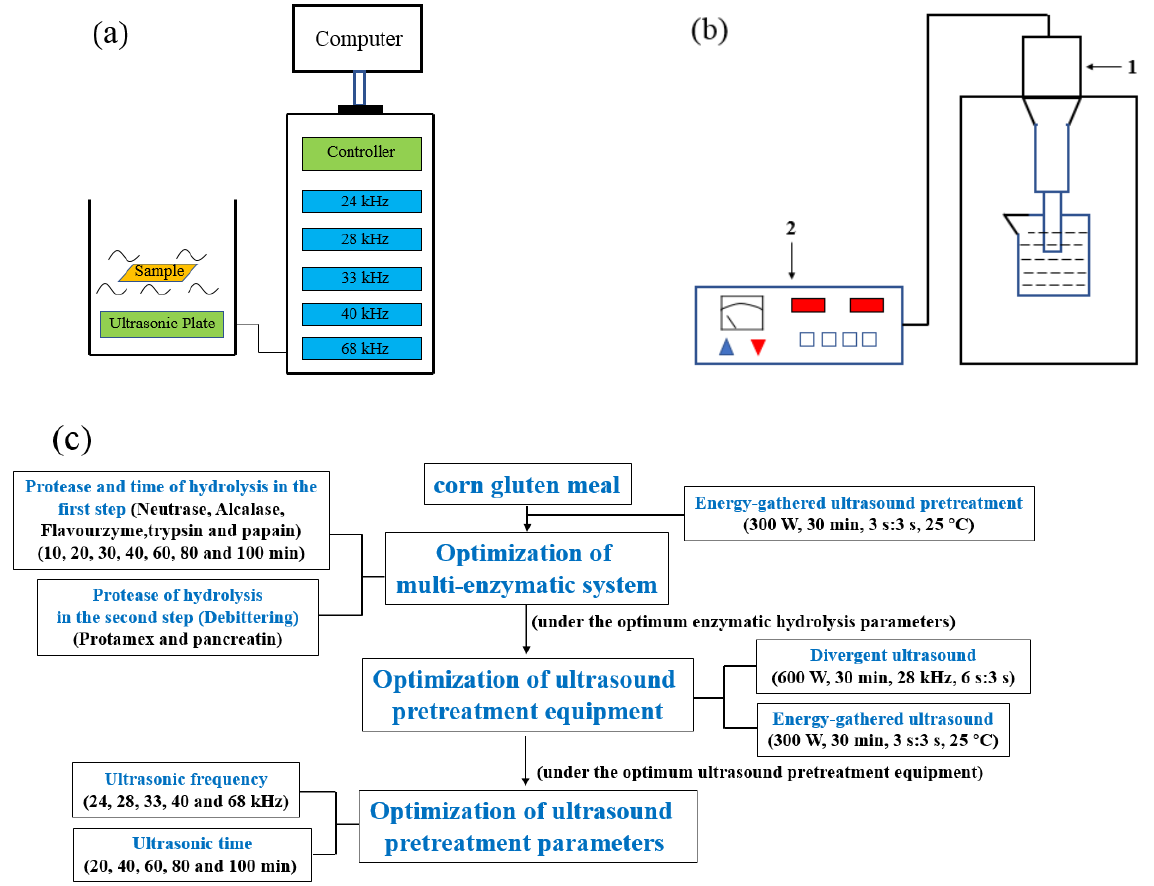
Figure 1. ( a ) Diagram of the divergent ultrasound equipment; ( b ) Diagram of the energy-gathered ultrasound equipment. 1: Ultrasonic probe; 2: Ultrasonic controller; ( c ) Experimental flow